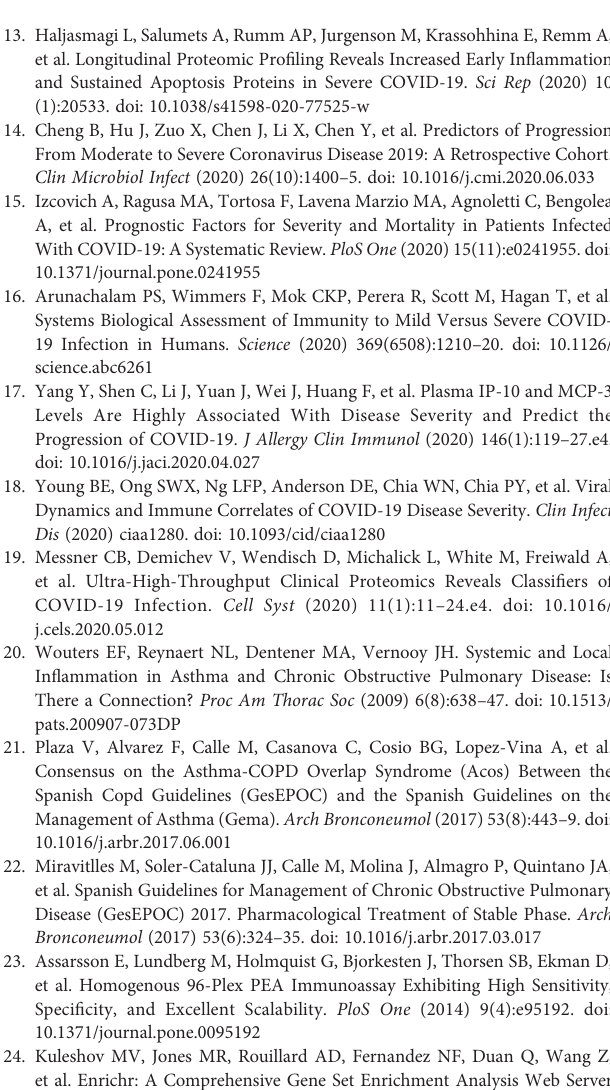
Supplementary Figure 1 | The HGF, OPG and TRANCE axis in patients and controls. (A) Schema on the protein-protein interactions between HGF and OPG mediated by fi bronectin (FN1), vitronectin (VTN) and the von- Willebrand factor (VWF). (B) Dot plots with the normalized protein levels (log 2 scale) in relation to age, each dot represents a subject. Lines represent the regression. Supplementary Figure 2 | Pearson correlation coef fi cients of the signi fi cant relationships between age and nine proteins associated with severe COVID-19 in healthy controls (HC), asthma and COPD patients. Supplementary Table 1 | Detailed information on the list of plasma proteins with signi fi cant differences between COPD patients and healthy